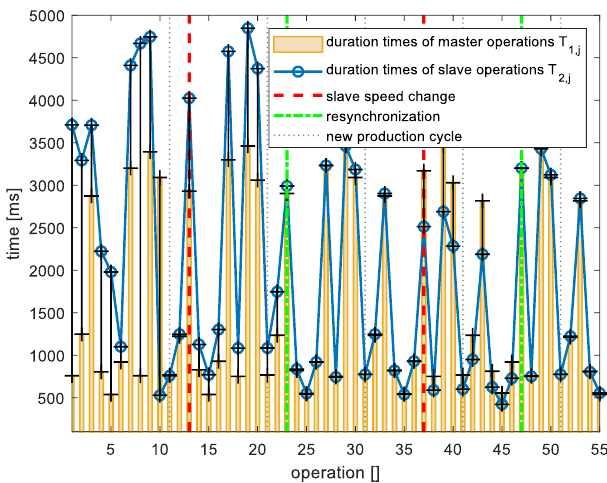
Figure 7. Operation duration times of master and slave manipulators without feedforward synchronization — Experiment 2a.